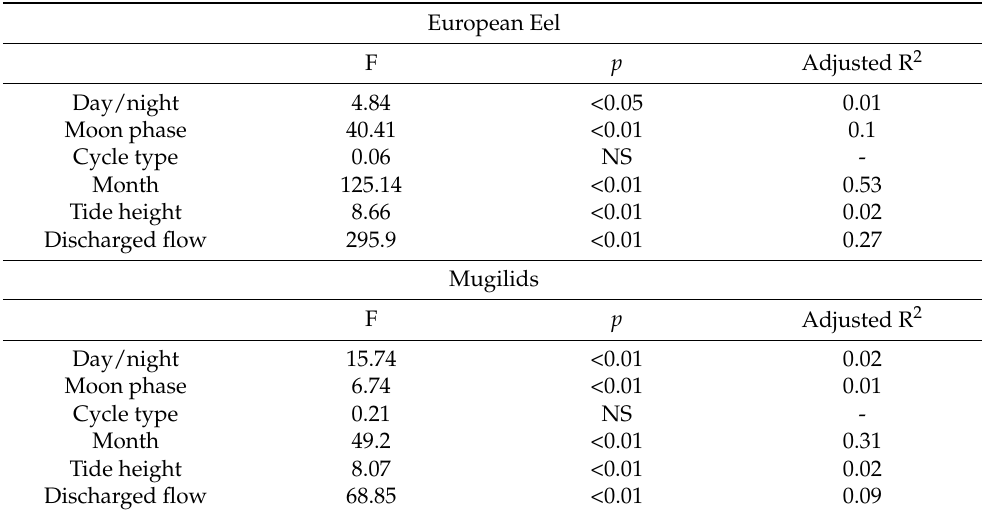
Table 4. Main results of the ANOVA for the number of individuals per cycle (ind.cyle − 1 ) according to explanatory variables